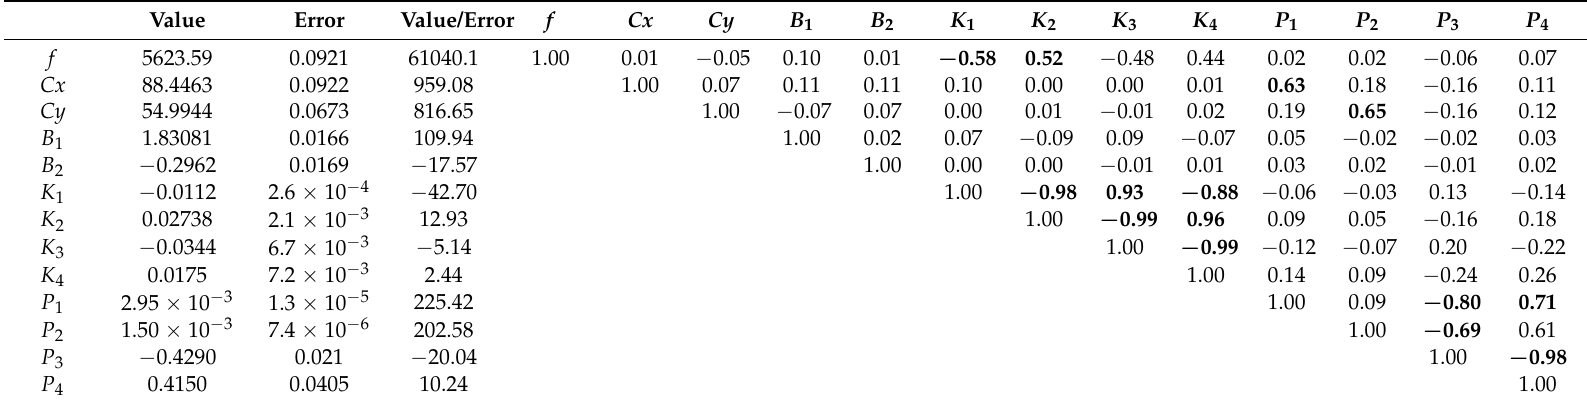
Table 1. Example of a camera calibration parameter set showing values, errors, value/error ratios and correlations. Correlations over 0.5 are in bold. (Source: Agisoft